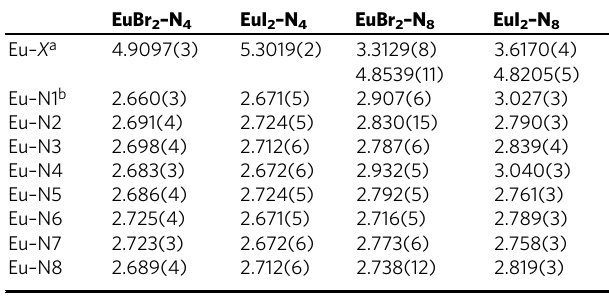
Table 1 The bond lengths (distances) around Eu 2 + center in Eu X 2 – N n